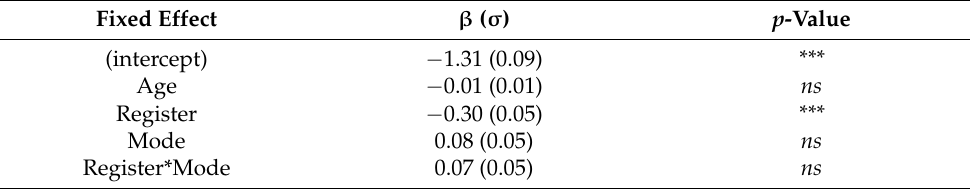
Table A2. Turkey. Regression table for binomial GLMM with the dependent variable Connector and the independent variables Age, and the interaction of Register and Mode. Outputs for by-Country binomial